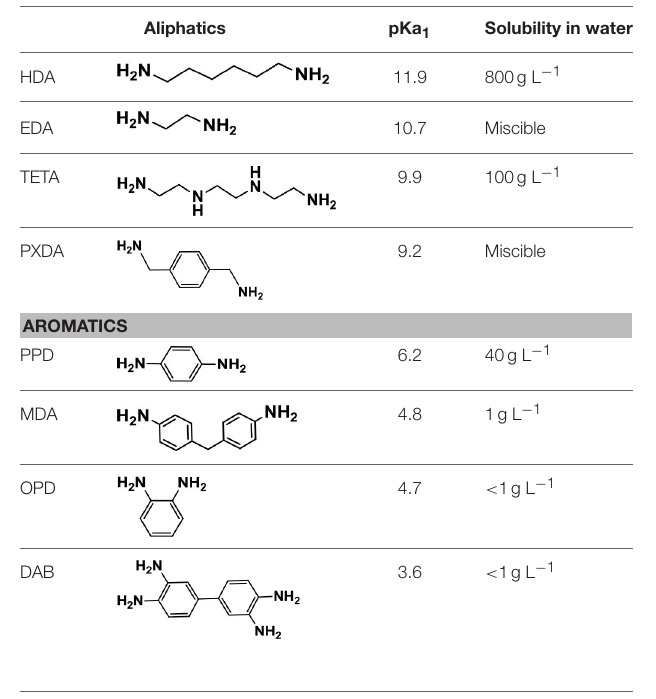
TABLE 1 | Diamines used as gelators for rGO hydrogels.